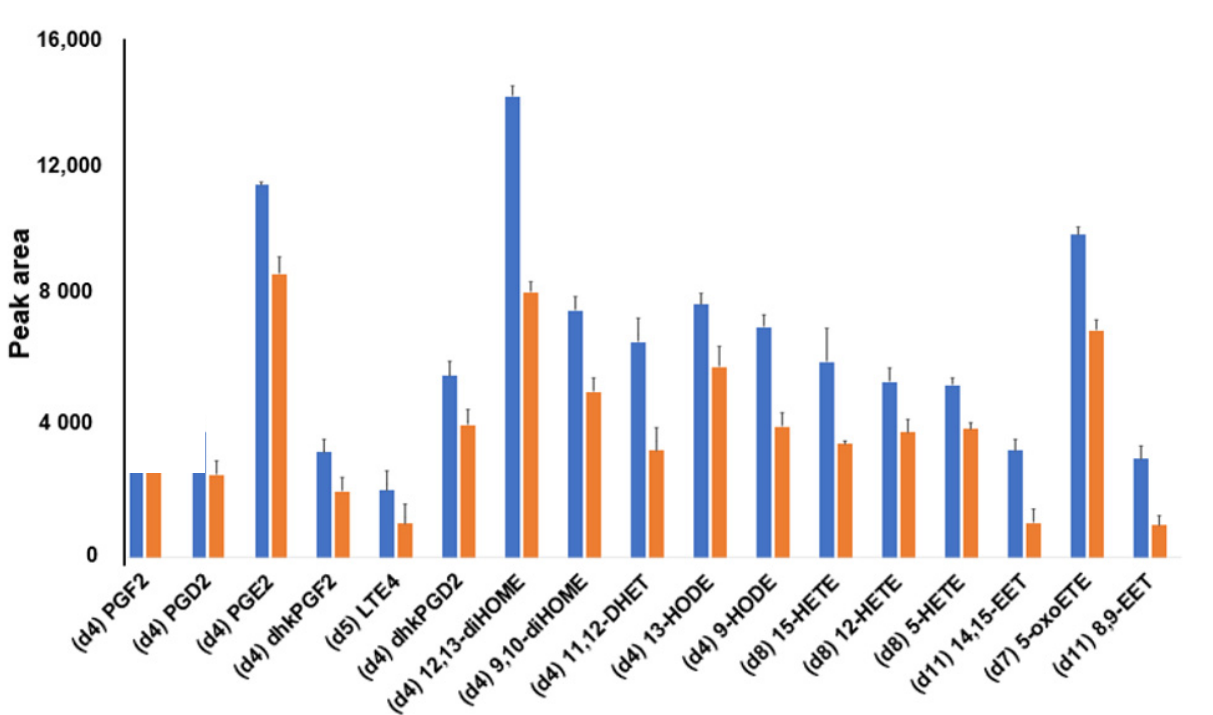
Figure 6. Comparison between MIP (blue) and NIP (orange) polymers for lipid mediators enrichment with 15% methanol and 0.5% acetic acid in the washing solvent. A mixture of internal standards spiked into blood plasma was used to test the recovery affinity of both materials. Bar charts represent Mean ±SD ( n = 3). SD—standard deviation.